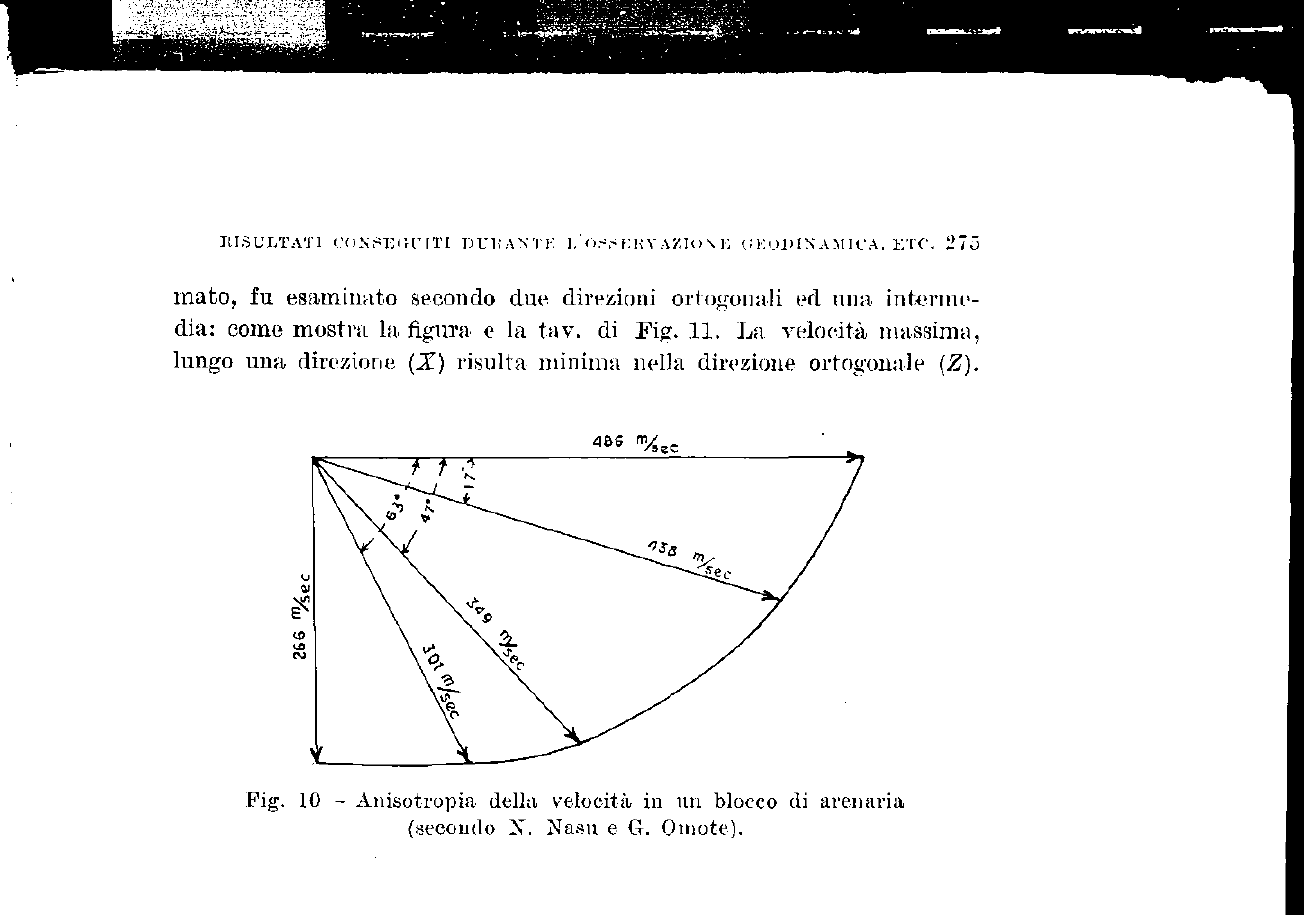
Fig. 10 - Anisotropia della velocità in un blocco di arenaria (secondo N. Nasu e G. Oniote).